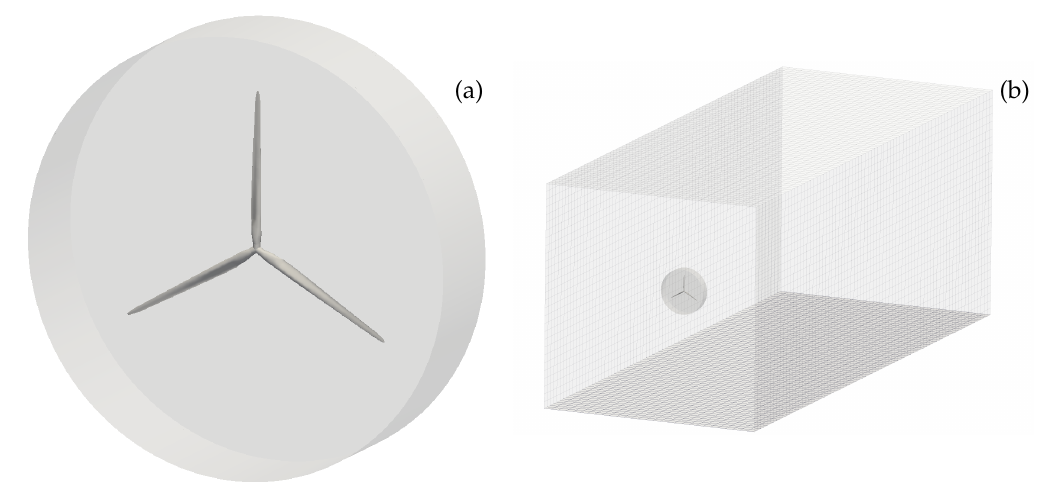
Figure 1. Grids of ( a ) rotating part and ( b ) full domain of Blade Resolved (BR)